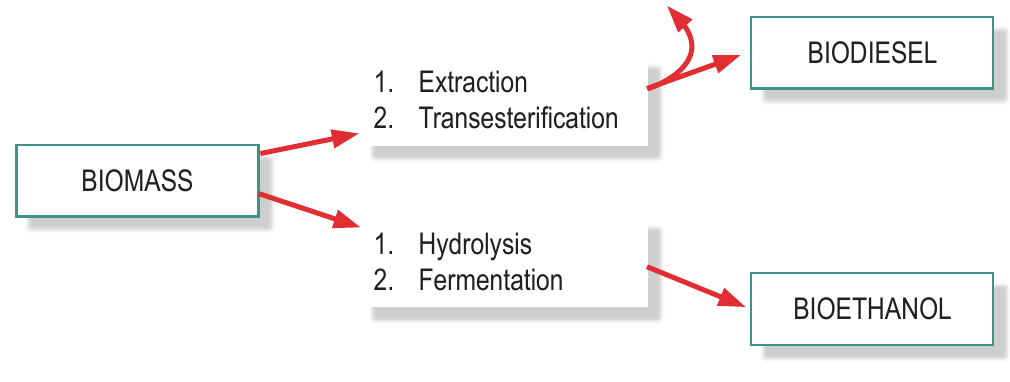
Figure 2. Biofuel production from